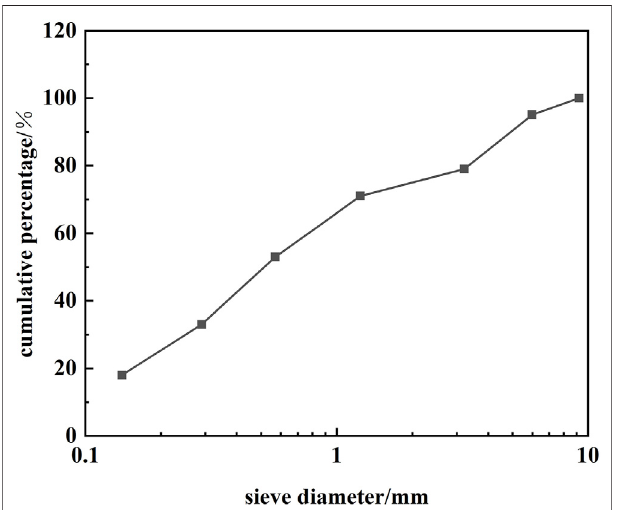
FIGURE 2 | Gradation of fi lling waste rock.